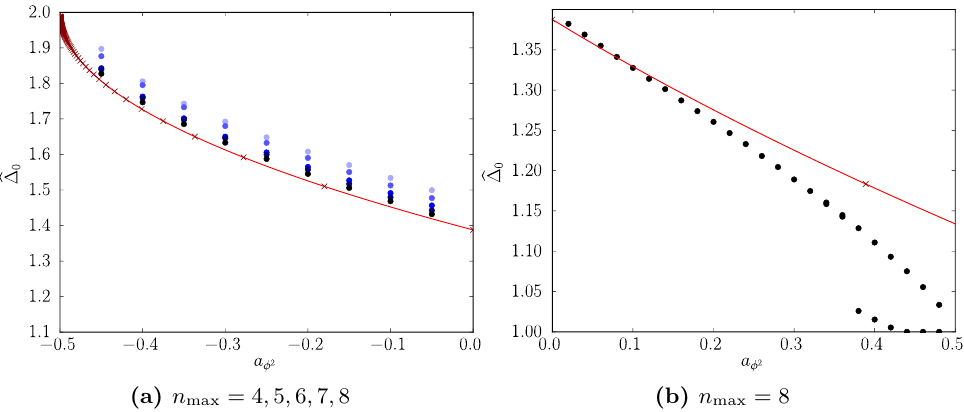
. On the left, we Figure 4. The maximal gap for unprotected scalars plotted as a function of a φ 2 focus on region I, which we take as a < 0 , where conformal perturbation theory works best. The φ 2 agreement between (3.18) and our data improves as the number of derivatives is increased. On the right, we have extended the plot to a > 0 but only for n max = 8 (black dots), the number of φ 2 derivatives used everywhere else in this paper. For most values of a , the maximal scalar gap is the φ 2 same whether or not we make assumptions about operators with spin 2. After reaching a ≈ 0 . 36 , φ 2 however, this is no longer the case. The upper set of points here comes from maximizing b ∆ with 0 no assumptions while the lower set of points comes from maximizing b ∆ along the line having 0 maximal b ∆ 2